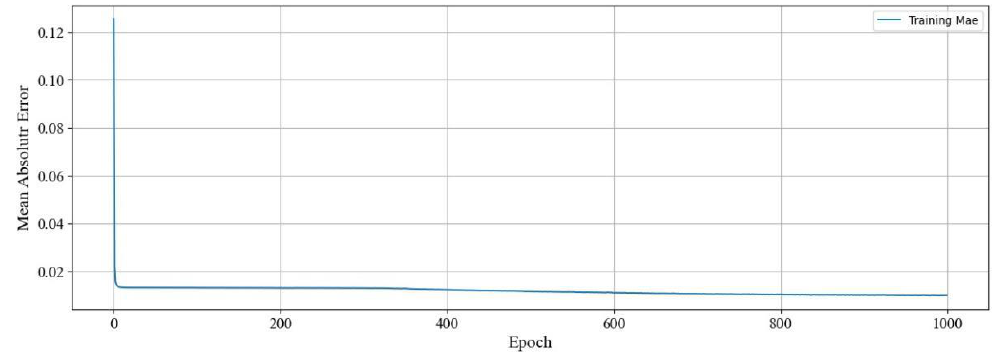
Figure 9. MAE of the LSTM-NN model after 1000 epochs of training.